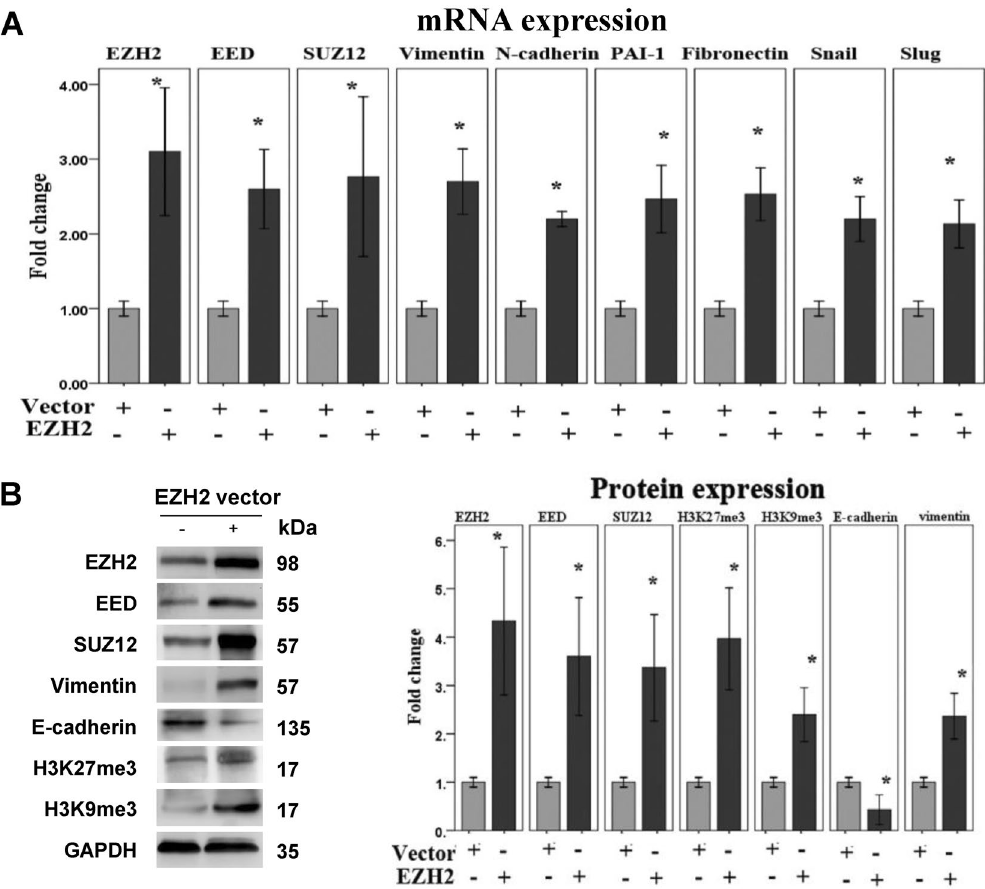
Figure 3. Overexpression of EZH2 promotes EMT in endometriotic epithelial cells. ( A ) qPCR analysis of indicated mRNAs in 11Z cells transfected with empty vector and EZH2 expression plasmids (n = 5). Values are normalized to GAPDH expression. ( B ) Representative images (left panel) and quantitative comparison (right panel) of indicated proteins in 11Z cells after overexpression of EZH2 (n = 5). The cropped blots are used in the figure. The membranes were cut prior to exposure so that only the portion of gel containing desired bands would be visualized, as described in materials and methods. * P <